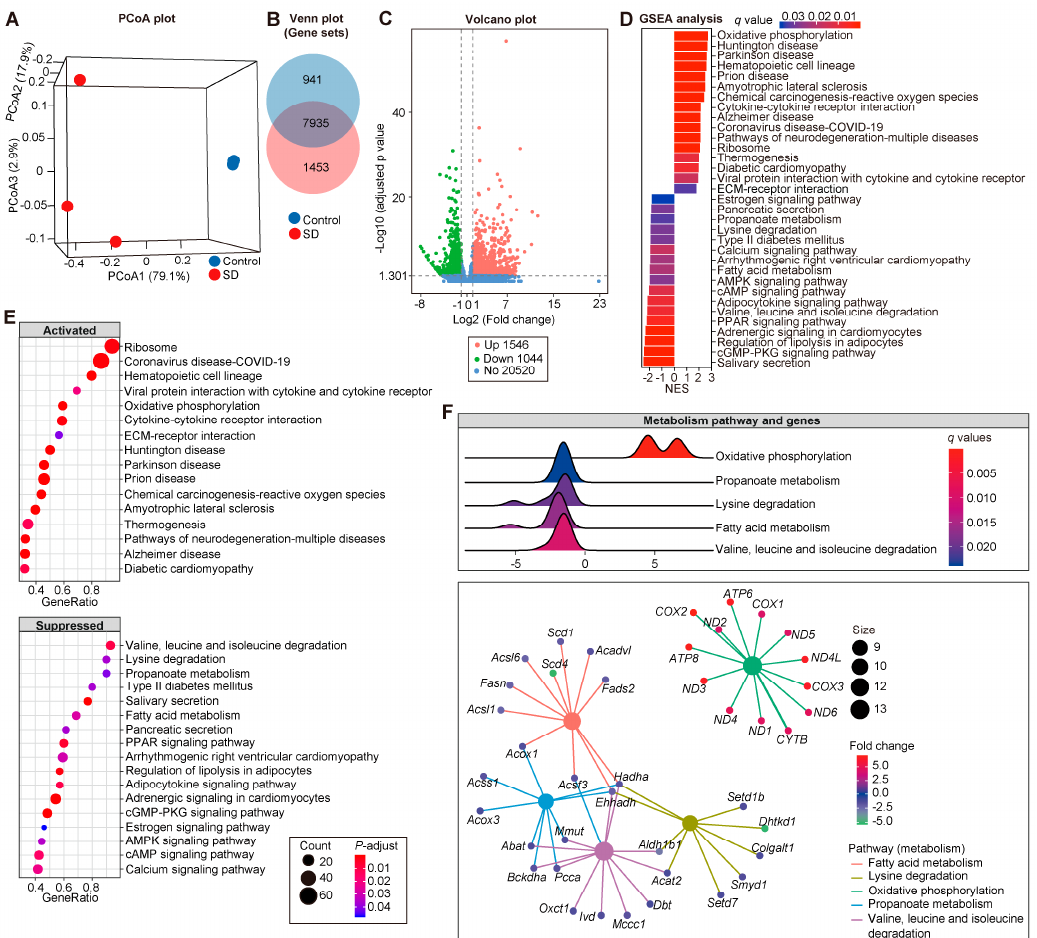
Figure 4. Modified transcriptional signatures in atria of SD mice. ( A ) Principal coordinates analysis (PCoA) based on Bray–Curtis distance. The green circles represent control and the purple circles denote SD. ( B ) Venn plot showed the mRNA detected in control and SD. ( C ) Volcano plots showing the results of DESeq2-based differential genes analyses. Adjusted p -value < 0.05 and |log2 (FoldChange)| > 1 were set as the threshold for significantly differential expression. Information of NES ( D ) and GeneRatio ( E ) of KEGG pathways revealed by the Gene Set Enrichment Analysis (GSEA) and the network ( F ) and ridge plot ( G ) of five metabolism-related pathways.